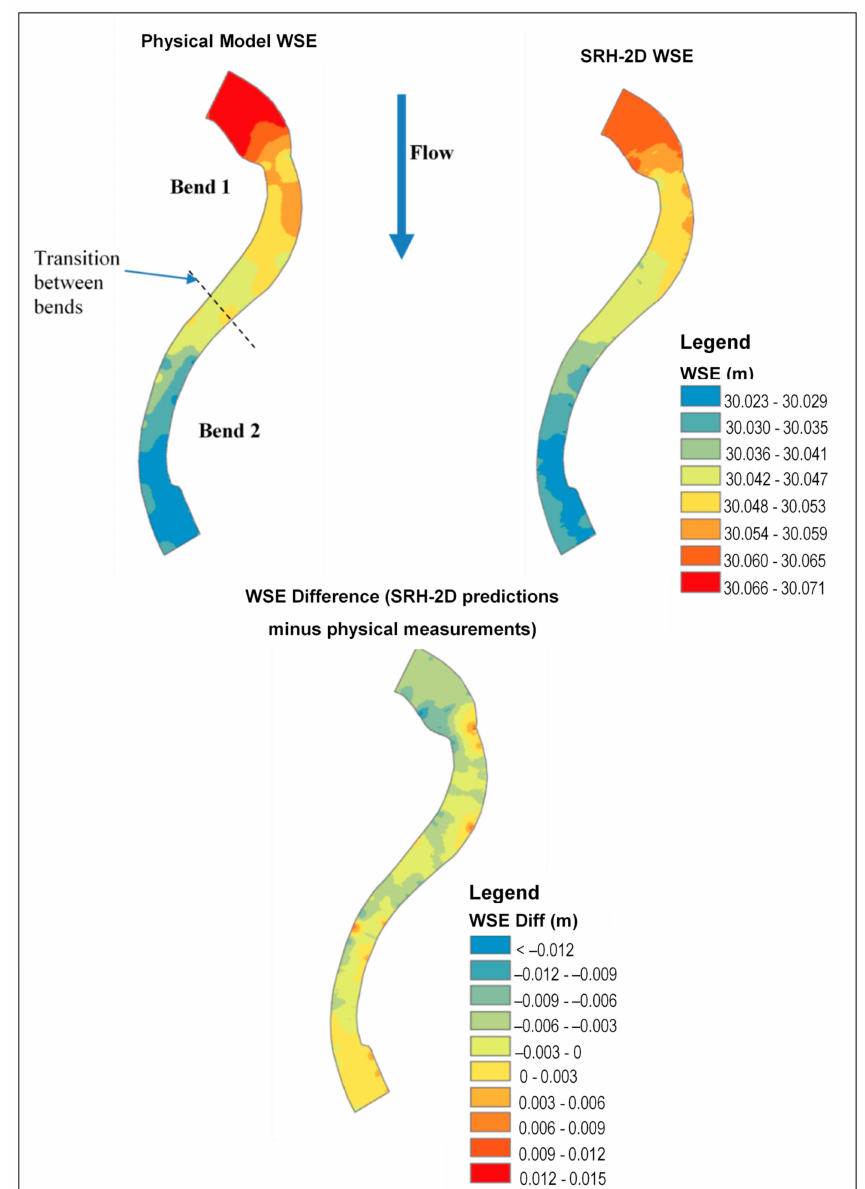
Figure 15. Baseline configuration comparison of physical model-measured and SRH-2D-predicted WSE